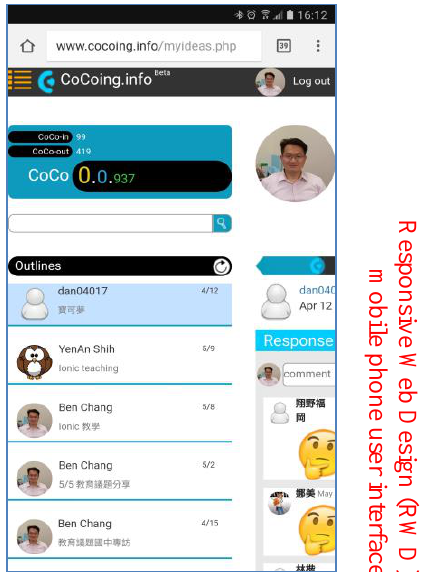
Figure 6. Concept list interface on a mobile phone